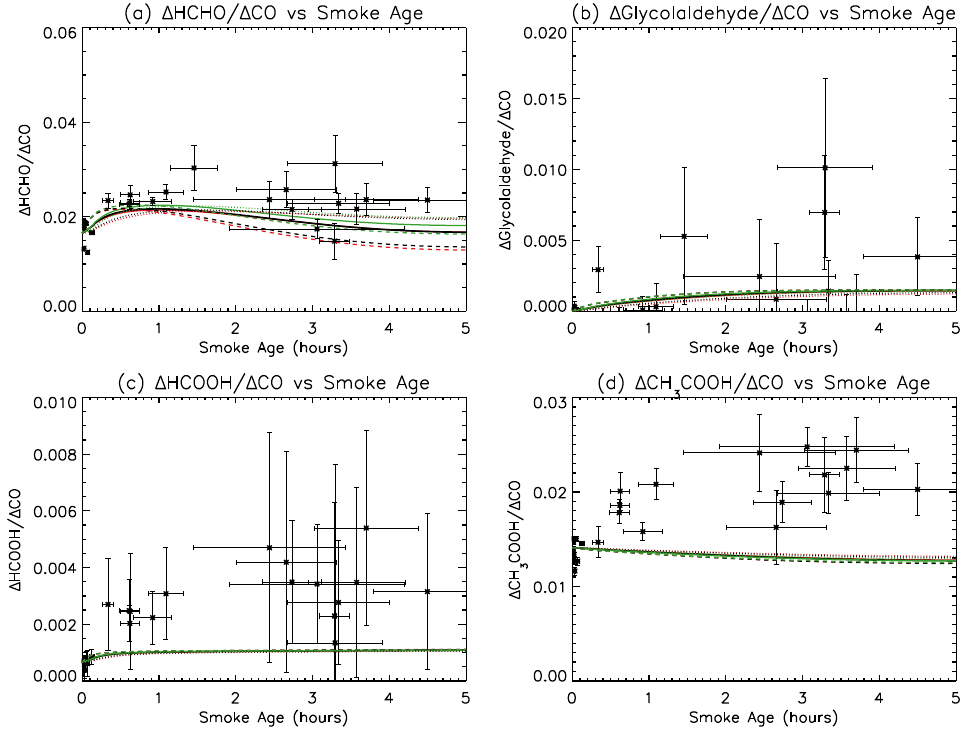
Figure 8. Enhancement ratio (EnR; molmol − 1 ) of (a) HCHO, (b) glycoaldehyde (HCOCH 2 OH), (c) formic acid (HCOOH), and (d) acetic acid (CH 3 COOH) to CO vs. estimated smoke age when the chemistry of the unidentified SVOCs is not included in the model. Asterisks are the measured mixing ratios, with the horizontal error bars showing the uncertainty in the estimated age and the vertical error bars showing the uncertainty in the measurement. Red, black, and green are ASP results for the slow, best fit (medium), and fast plume dilution rates. Dashed lines are for above-plume photolysis rates, while solid lines are for the in-plume rates, as described in the text.